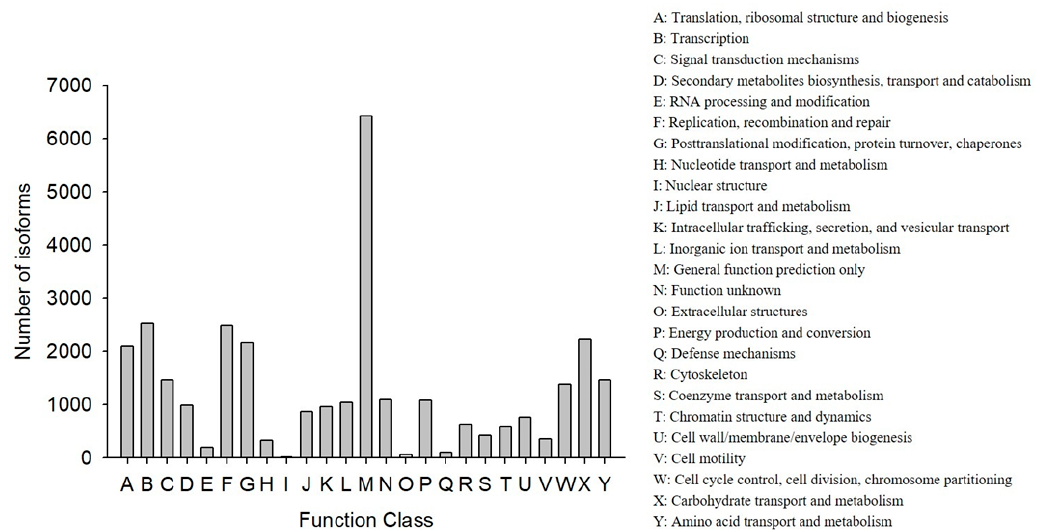
Figure 3. Functional distribution of the Cluster of Orthologous Groups (COG) annotation. The x-axis represents the COG function category. The y-axis represents the number of isoforms.